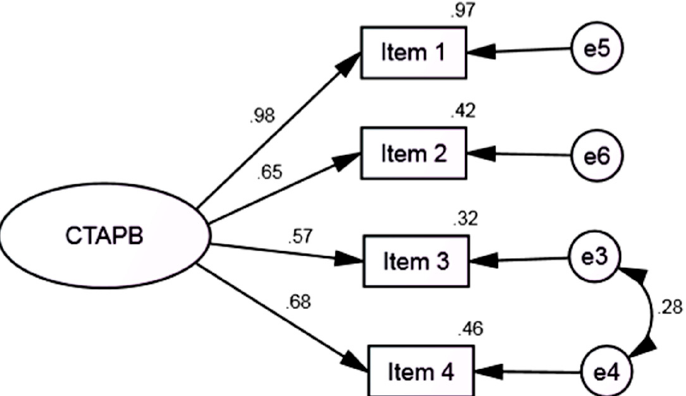
Figure 2. CFA model of latent factor of Compulsory Temporary Afterlife Punishment Belief (CTAPB)—Study 2.